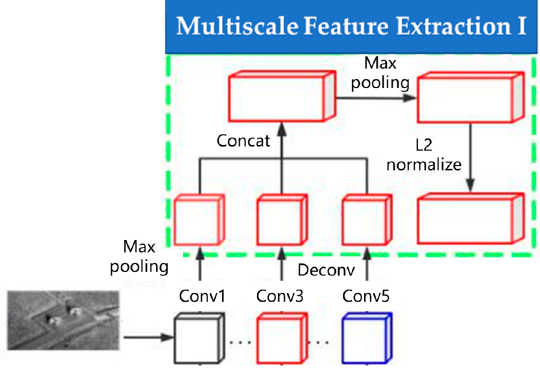
Figure 2. Multiscale feature extraction I.